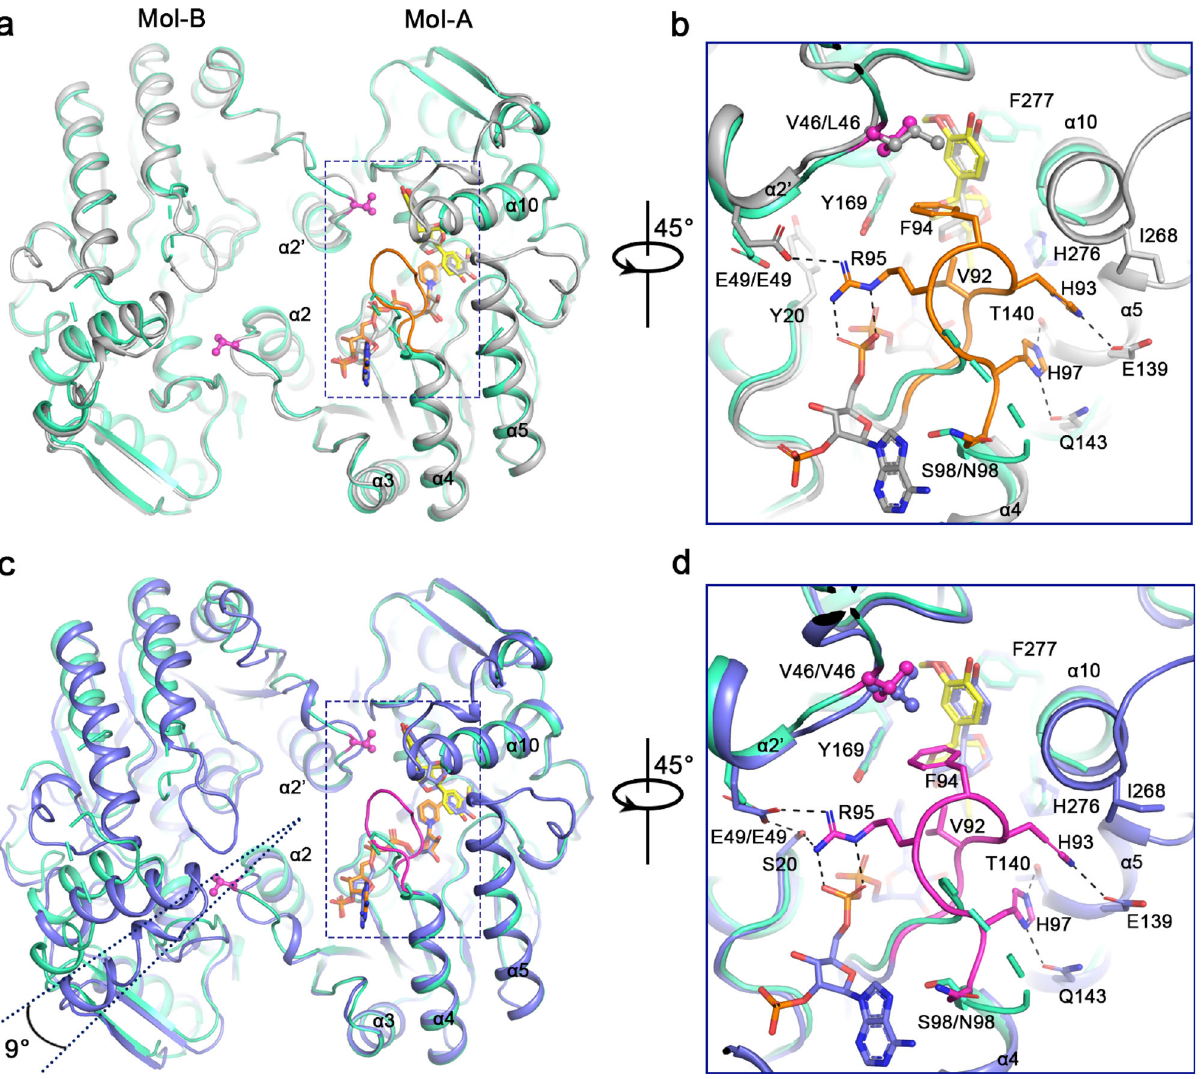
Fig. 3 Structural differences among Ii PLR1, At PrR1, and At PrR2 indicating different catalytic capacities. a Structural alignment of dimerized Ii PLR1_NAP_ + PIN (green cyan) and At PrR1_NAP_ + PIN (light gray). b Zoom-in view of dashed box in a . The β 4 loop of At PrR1_NAP_ + PIN is highlighted in orange. c Structural alignment of dimerized Ii PLR1_NAP_ + PIN (green cyan) and At PrR2_NAP_ + PIN (slate blue). d Zoom-in view of the dashed box in c . The β 4 loop of At PrR2_NAP_ + PIN is highlighted in magenta. For brevity, NADP + and some residues in Ii PLR1 are hidden. The cartoons are generated by